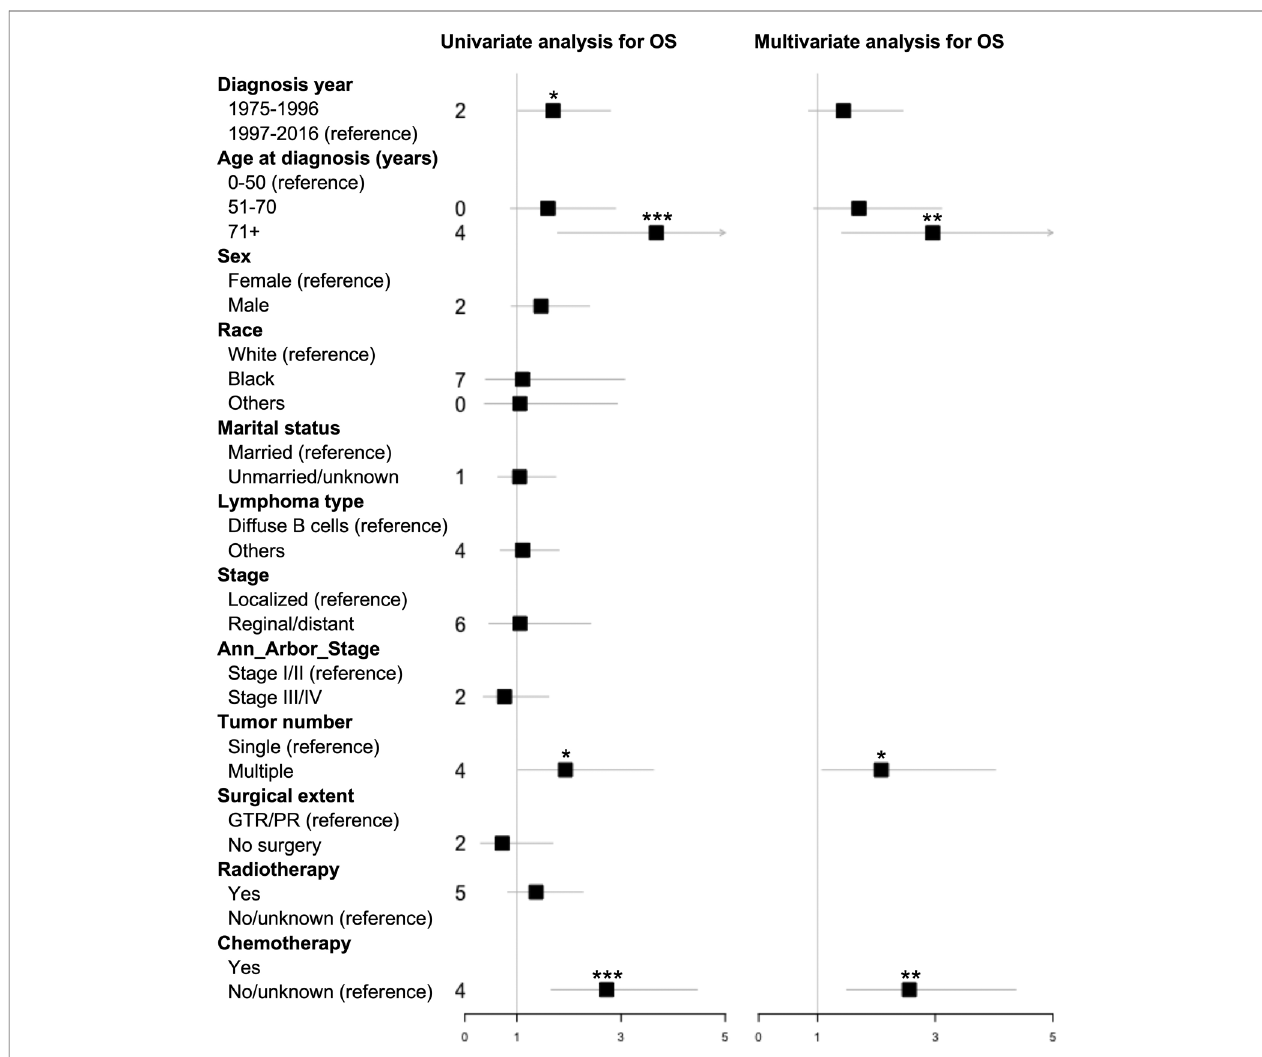
FIGURE 3 | Forest plot based on univariate and multivariate Cox proportional hazard analysis of overall survival (OS) for PBSL patients. GTR, gross total resection; OS, overall survival; PR, partial resection. *, P <0.05; **, P <0.01; ***, P